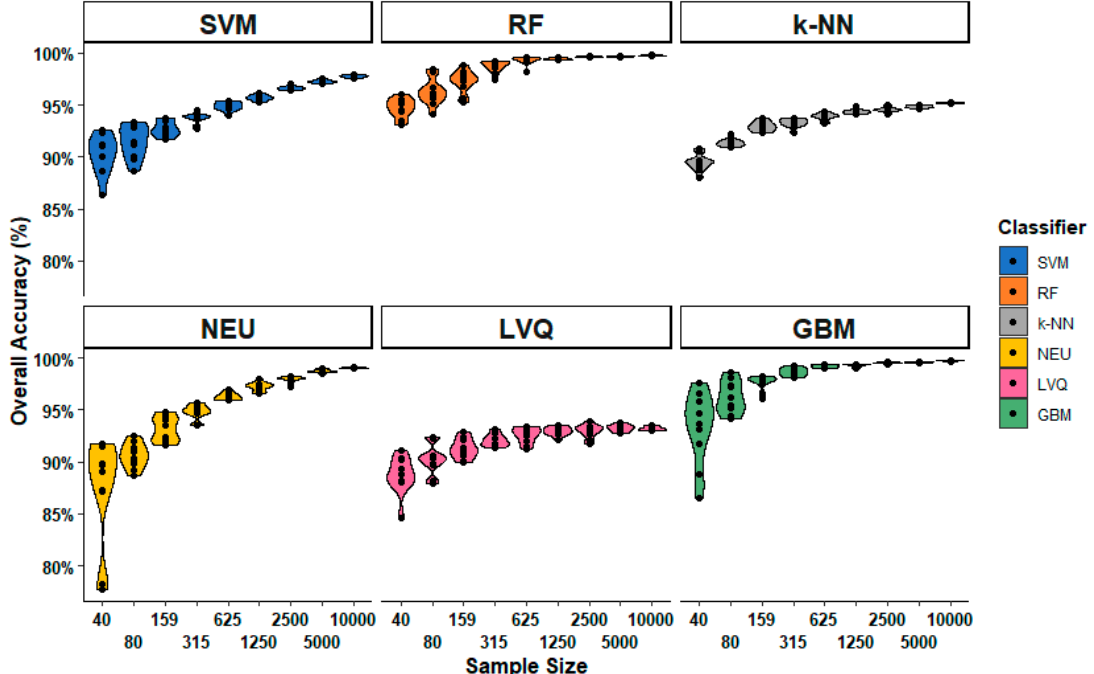
Figure 4. Distribution of overall accuracy for each classification method as a function of sample size.